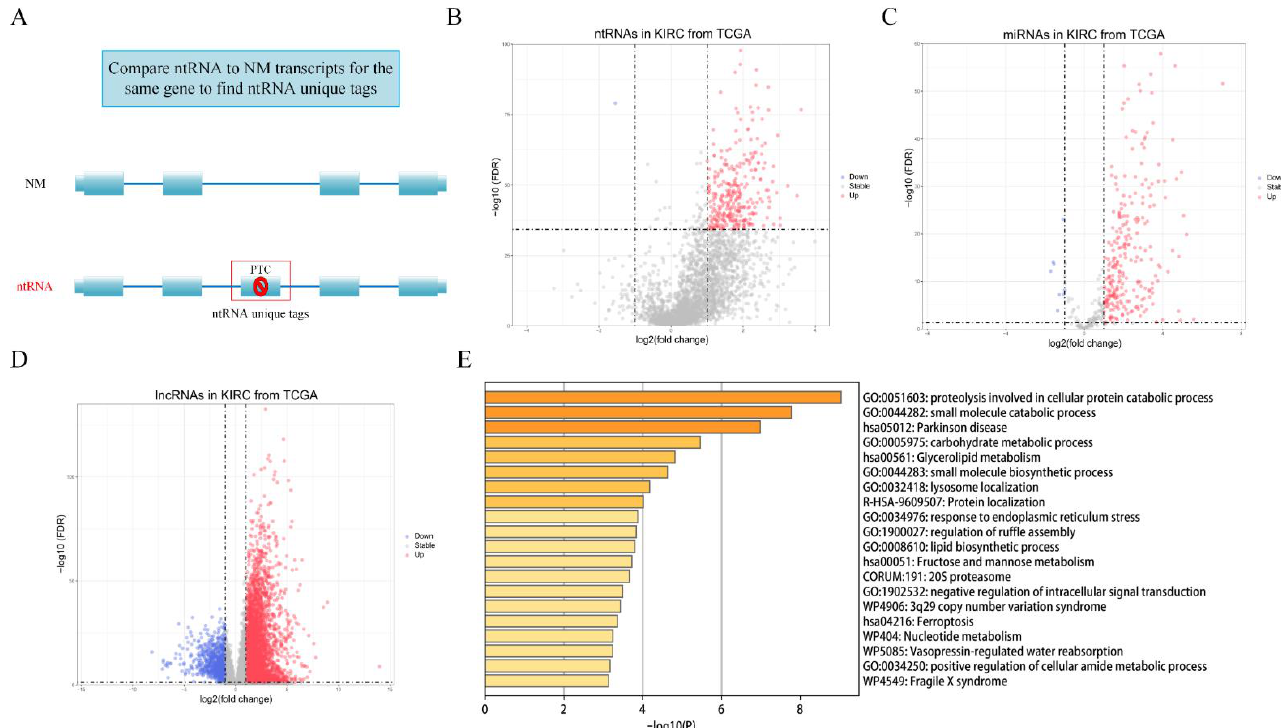
Figure 2. Selection of ntRNAs and DEGs. ( A ) Definition of ntRNA unique tags. ( B – D ) Volcano plots of 6720 ntRNAs, 377 miRNAs, and 8668 lncRNAs. ( E ) Top 20 significant enriched GO and pathways of 263 genes containing ntRNAs.